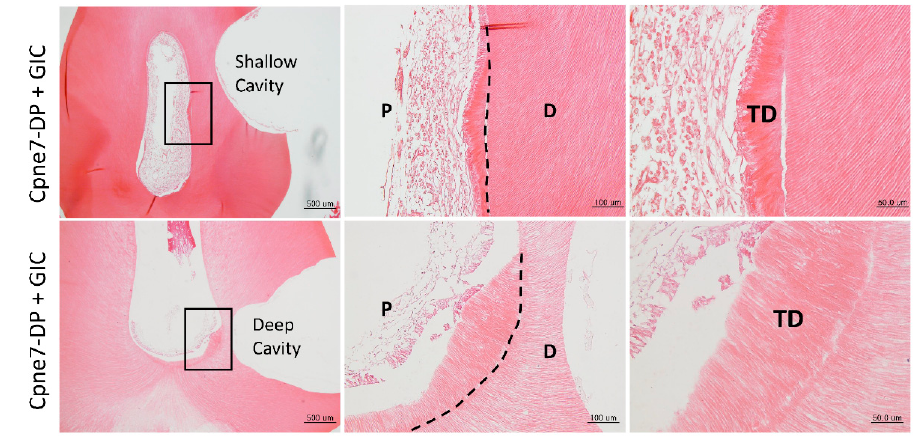
Figure A4. Histologic analysis six weeks after in vivo treatment of Cpne7-DP. Histological analysis of dental pulp responses at the shallow cavity and deep cavity preparation areas treated with Cpne7-DP after six weeks by hematoxylin and eosin staining ( n = 6). Dashed line indicates the remaining original dentin / newly formed dentin interfaces.